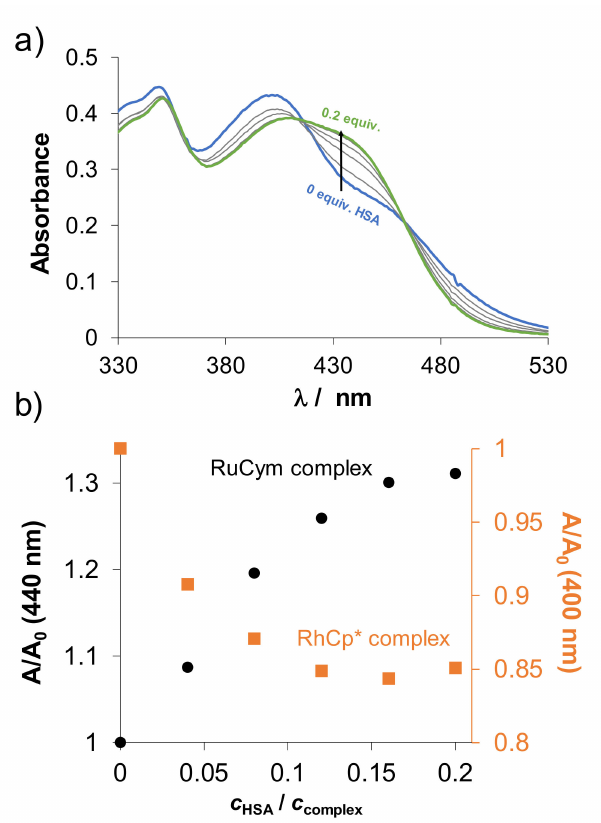
Figure 9. ( a ) UV-vis spectra of RuCym–HQCl-D-hPro complex in the presence of various equiv. HSA. (Arrows show the spectral changes with increasing equiv. HSA) ( b ) Relative absorbance changes against c HSA / c complex ratio of RuCym–HQCl-D-hPro complex ( • ) in comparison with RhCp*–HQCl- D-hPro ( (cid:4) ). (A is the measured absorbance at 440 nm at the given ratio, A 0 is the initial absorbance of the complex without HSA.) { c complex = 100 µ M; c HSA = 0–20 µ M; T = 25.0 ◦ C; (cid:96) = 1 cm; pH = 7.40